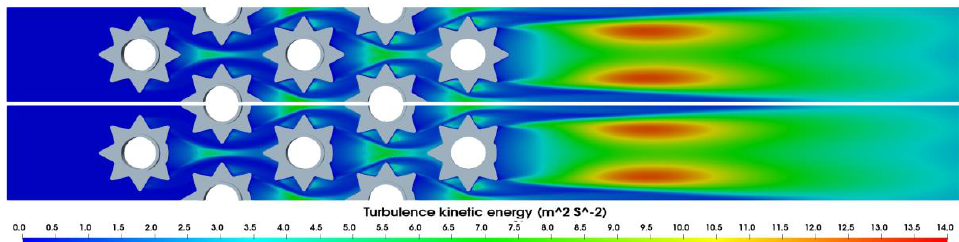
Figure 7. Velocity fields for star-shaped fins and trimmed fins.